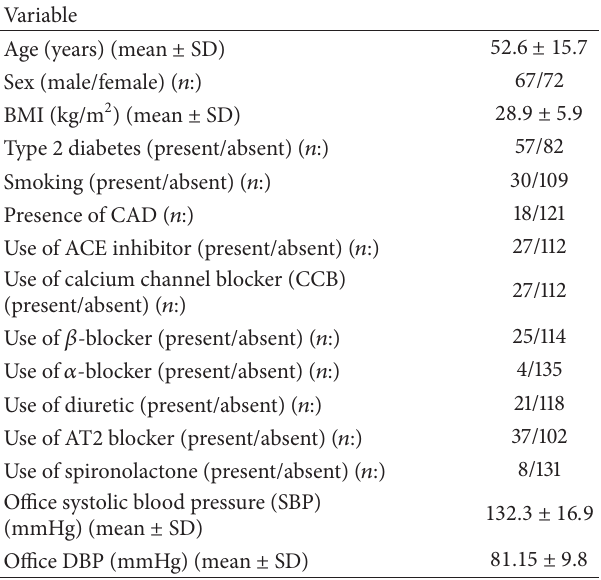
Table 1: The demographic and clinical parameters of 139